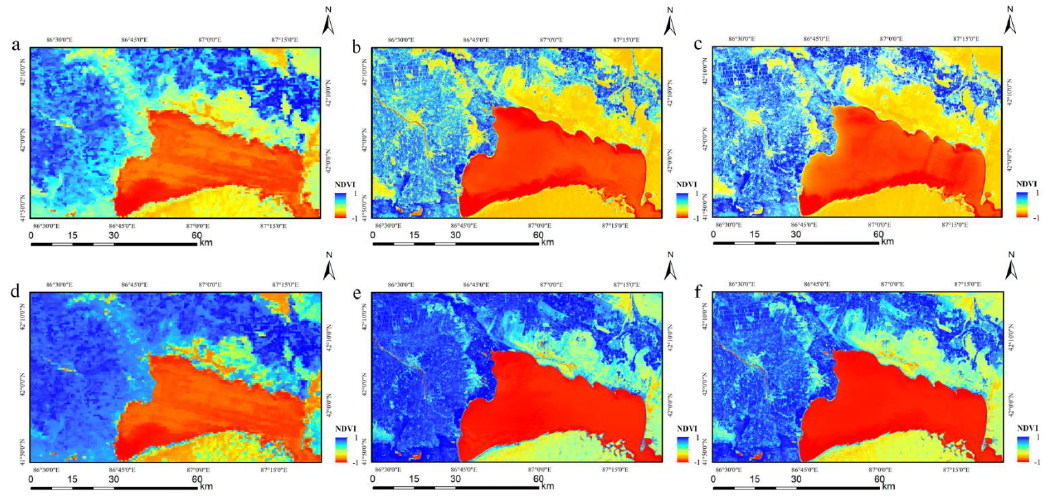
Figure 9. The observed NDVI and predicted NDVI. ( a – c ) show the MODIS NDVI, the predicted NDVI of Expt.1, and the predicted NDVI of Expt.2, on 10 July and ( d – f ) show the MODIS NDVI, the predicted NDVI of Expt.1, and the predicted NDVI of Expt.2, on 21 August.